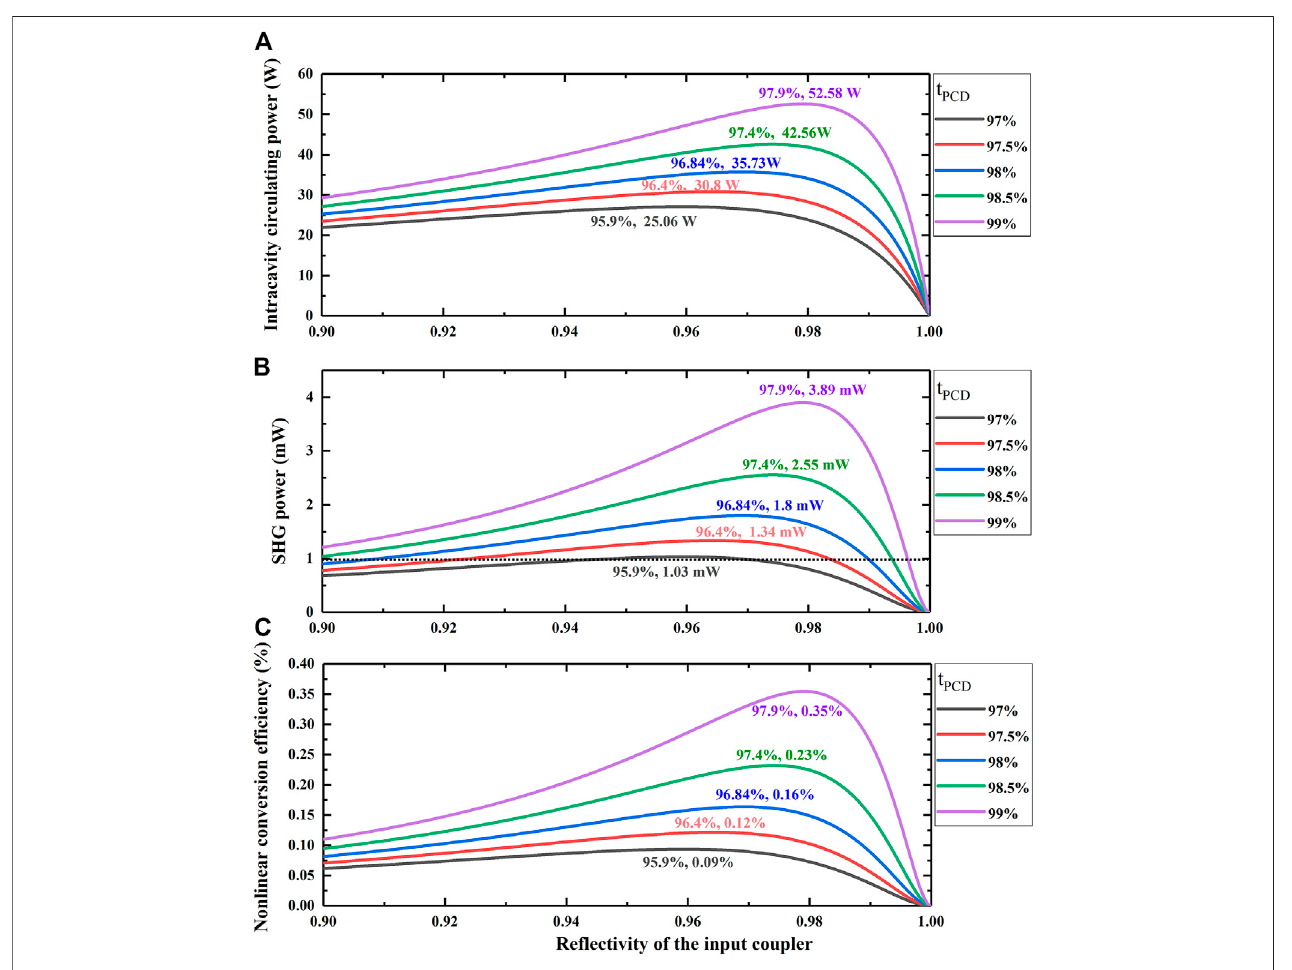
FIGURE 4 | (A) Intracavity circular power, (B) second-harmonic generation output power, and (C) nonlinear conversion ef fi ciency versus input coupler.